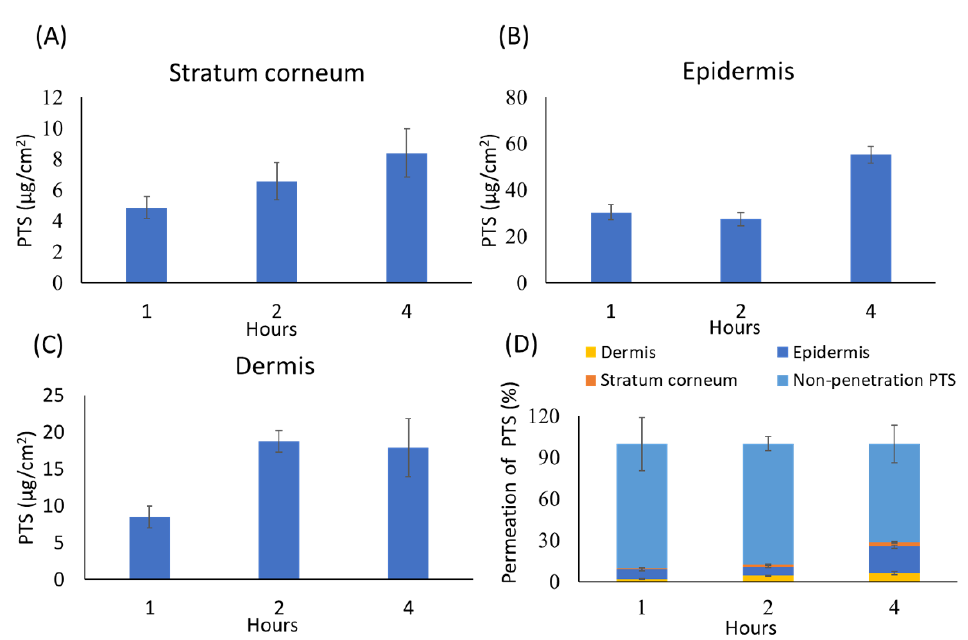
Figure 7. The contents of PTS in different skin layers. ( A ) Stratum corneum, ( B ) epidermis and ( C ) dermis. ( D ) The percentage of PTS that penetrated into different skin layers. Values are mean ± SD ( n = 5).